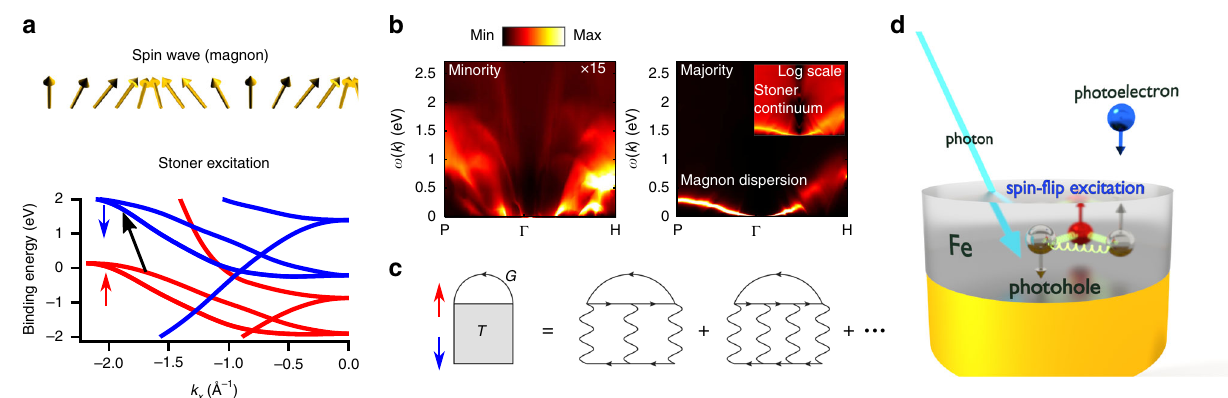
Fig. 1 Spin- fl ip effects in bcc Fe and schematics of the theoretical and experimental approach used in the present study. a Schematic representation of a collective spin wave and a single-particle Stoner excitation. b Calculated momentum and energy dependence of spin excitations in bcc Fe shown separately for minority excitations (left) and majority excitations (right) (spin fl ip of a minority and majority electron with a change of total spin of + 1 and − 1, respectively). The color scale on the left image is multiplied by a factor of 15. The inset in the right image presents the same spectrum but plotted in the logarithmic color scale to visualize the Stoner continuum. c Diagrammatic expansion of the GT self-energy. Black arrows denote Green functions, and wiggly lines represent the screened interaction. Blue/red arrows denote spin character. d Schematics of the spin-resolved momentum microscopy experiment measuring the formation of a bound state consisting of a minority (spin-down) photohole and an electron-hole pair in the majority (spin-up) channel, the photohole and the electron forming a correlated spin- fl ip